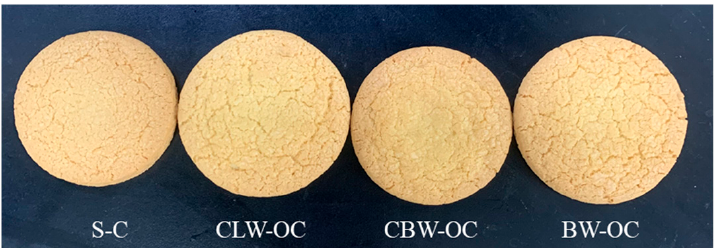
Figure 5. Visual appearance of cookies containing shortening and different oleogels. S-C: shortening cookie, CLW-OC: candelilla wax-oleogel cookie, CBW-OC: carnauba wax-oleogel cookie, BW-OC: beeswax-oleogel cookie. Table 3. Color, physical properties, and texture characteristics of cookies with oleogels.